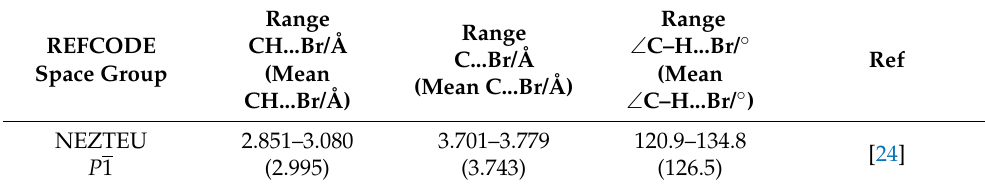
Figure 2. Bromide embrace motif in trans- [Ru(bpy) 2 Br 2 ]Br (refcode NEZTEU) [24] showing eight H3…Br − , H3 ′ ...Br − , H5...Br − , and H6...Br − contacts and eight RuBr...H4 and RuBr...H4 ′ interactions. Table 1. Parameters for CH bpy ...Br − ion contacts in trans- [Ru(bpy) 2 Br 2